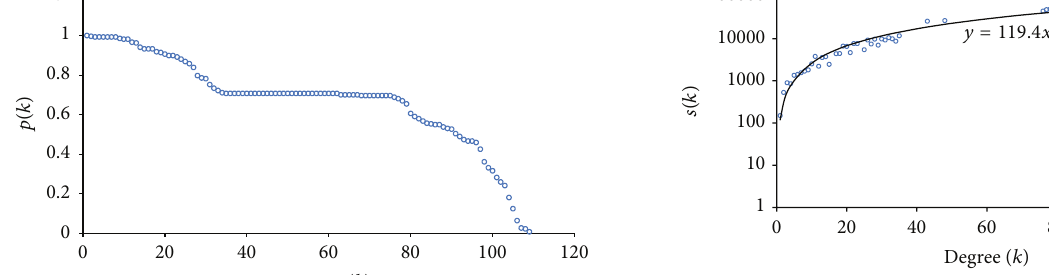
Figure 3: Strength as a function of